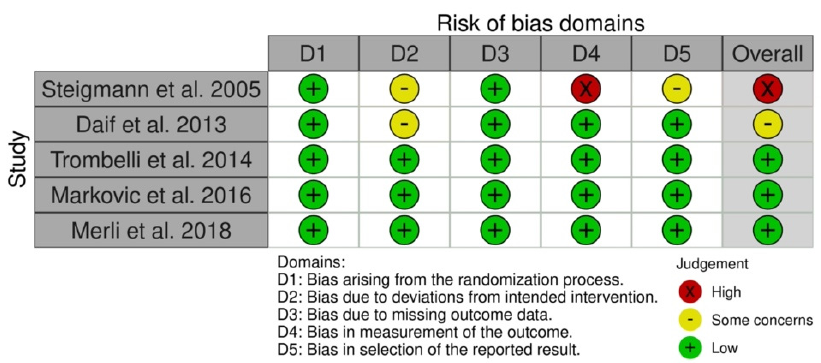
Figure 2. Risk of bias within the included RCTs.